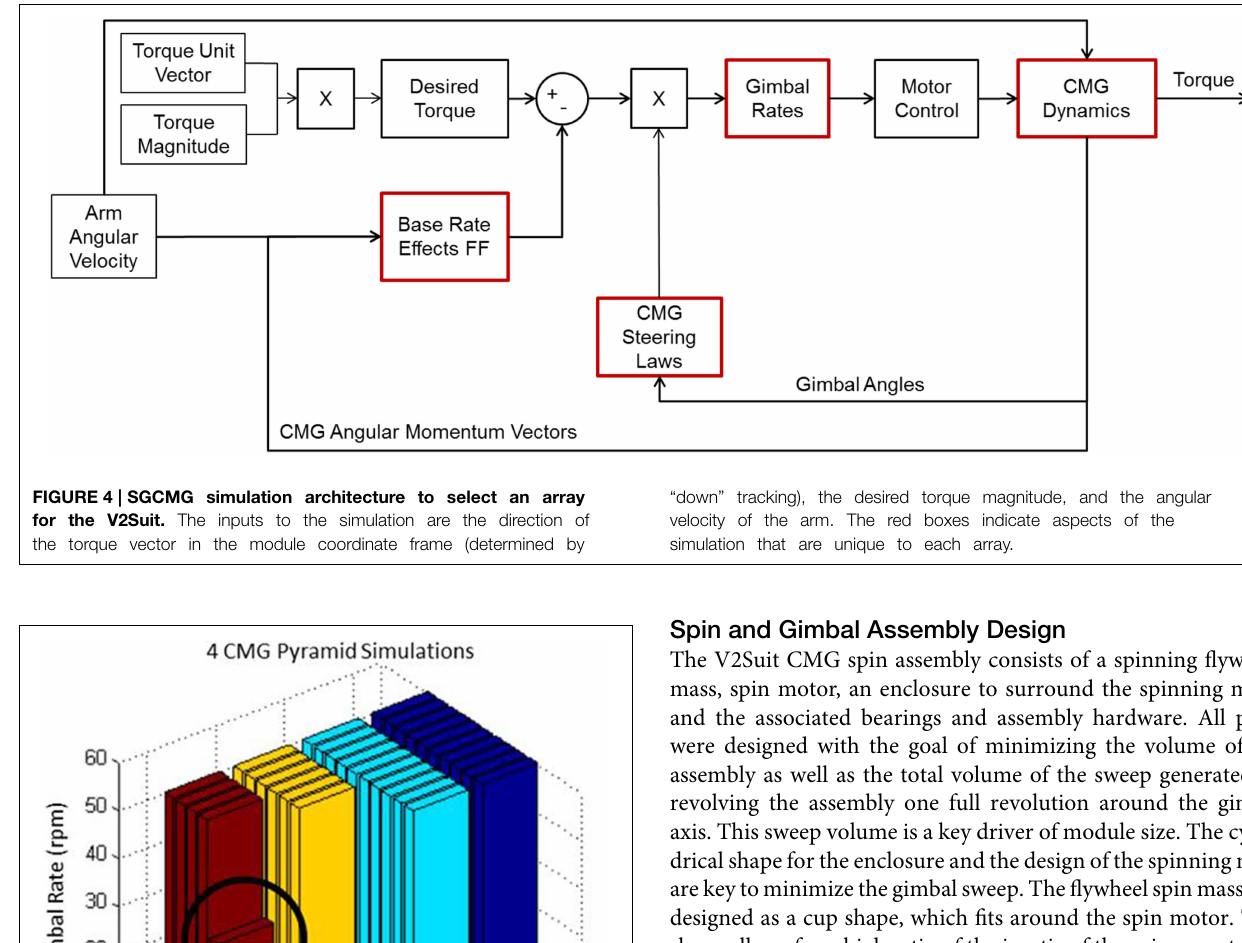
FIGURE 5 | Parametric results from the four CMG pyramid simulations. The ideal parameters are a flywheel spin rate of 15,000rpm with an inertia of approximately 450 g * cm 2